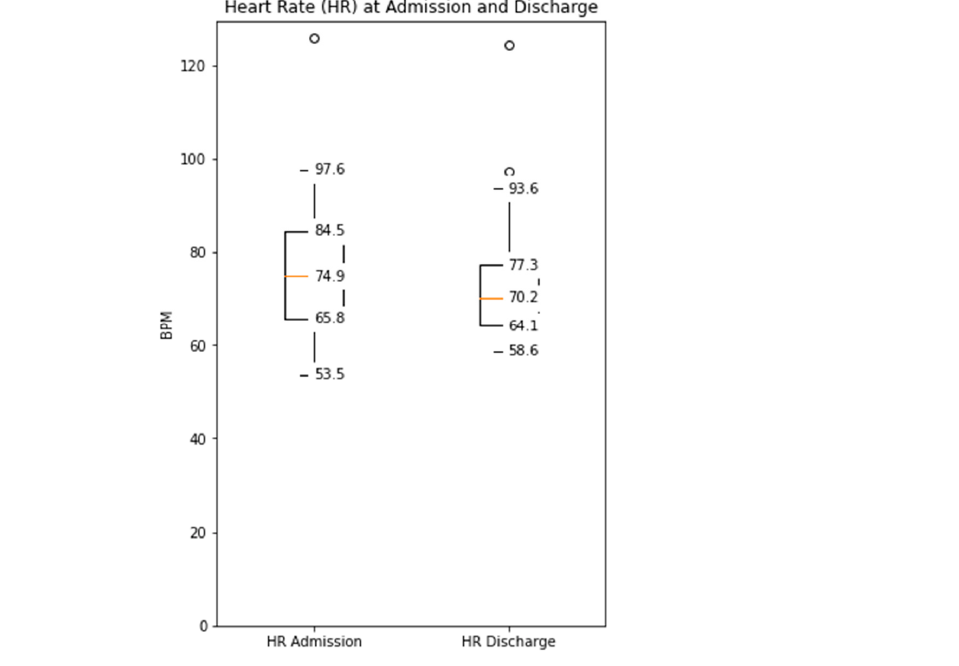
Figure 3. Median daily heart rate measured by the WCD at the time of admission and discharge to the CR clinic (Decreased from a median 74.9 bpm (IQR 65.8–84.5) to 70.2 (IQR 64.1–77.3), p = 0.09). For each WCD dataset, correlation to the validated 6MWT at the time of admission and discharge from CR clinic was calculated.